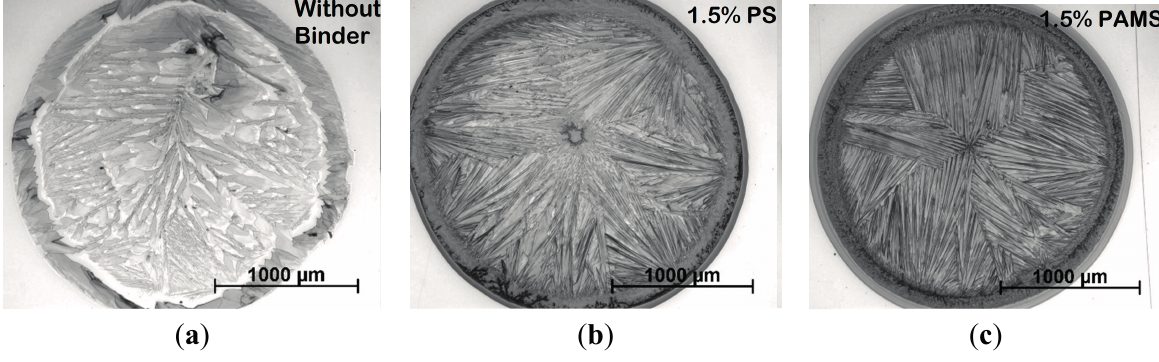
Figure 8. Microscope images of the drops of experimental part IV ( a ) without binder, ( b ) with 1.5% (wt) PS and ( c ) with 1.5% (wt) of PAMS.